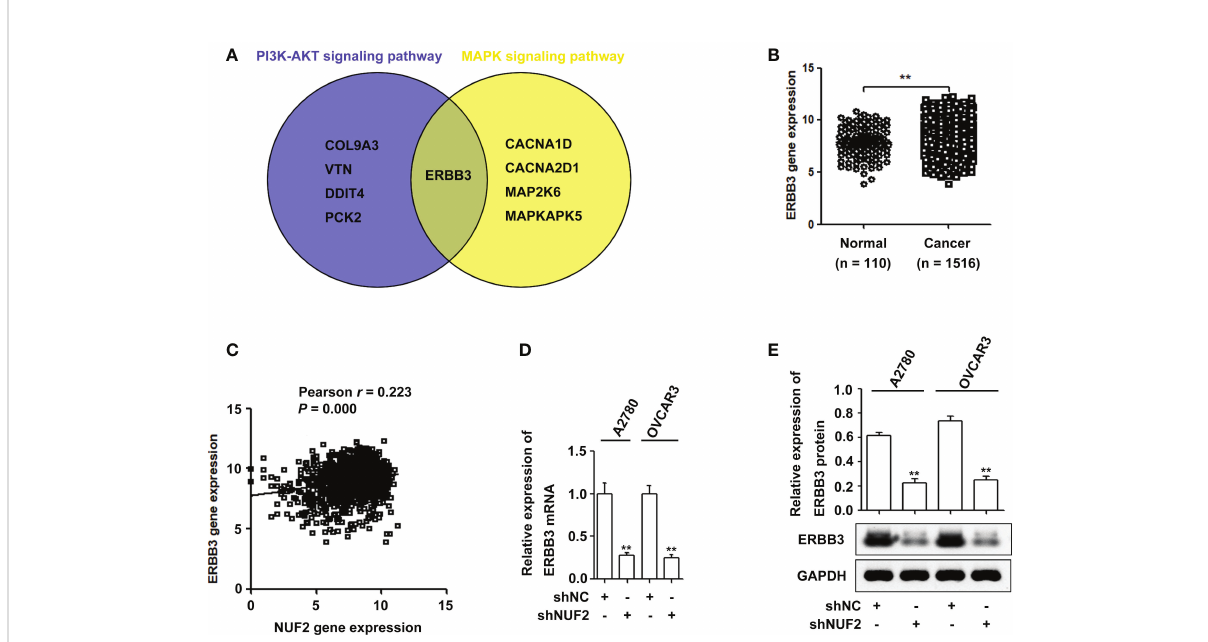
FIGURE 4 NUF2 downregulation inhibits ERBB3 expression in EOC cells. (A) A Venn diagram was used to represent common genes between the PI3K-AKT and MAPK signaling axes. (B) ERBB3 gene expression was signi fi cantly higher in EOC tissues than in the normal ovarian epithelial tissues. ** P < 0.01. (C) The Pearson correlation analysis was used to explore the association between NUF2 and ERBB3 expression ( r = 0.223, P = 0.000). (D) and (E) The mRNA and protein levels of ERBB3 were signi fi cantly reduced in NUF2 silenced cells when compared with A2780 and OVCAR3 cells transfected with shNC. ** P < 0.01 vs. the shNC